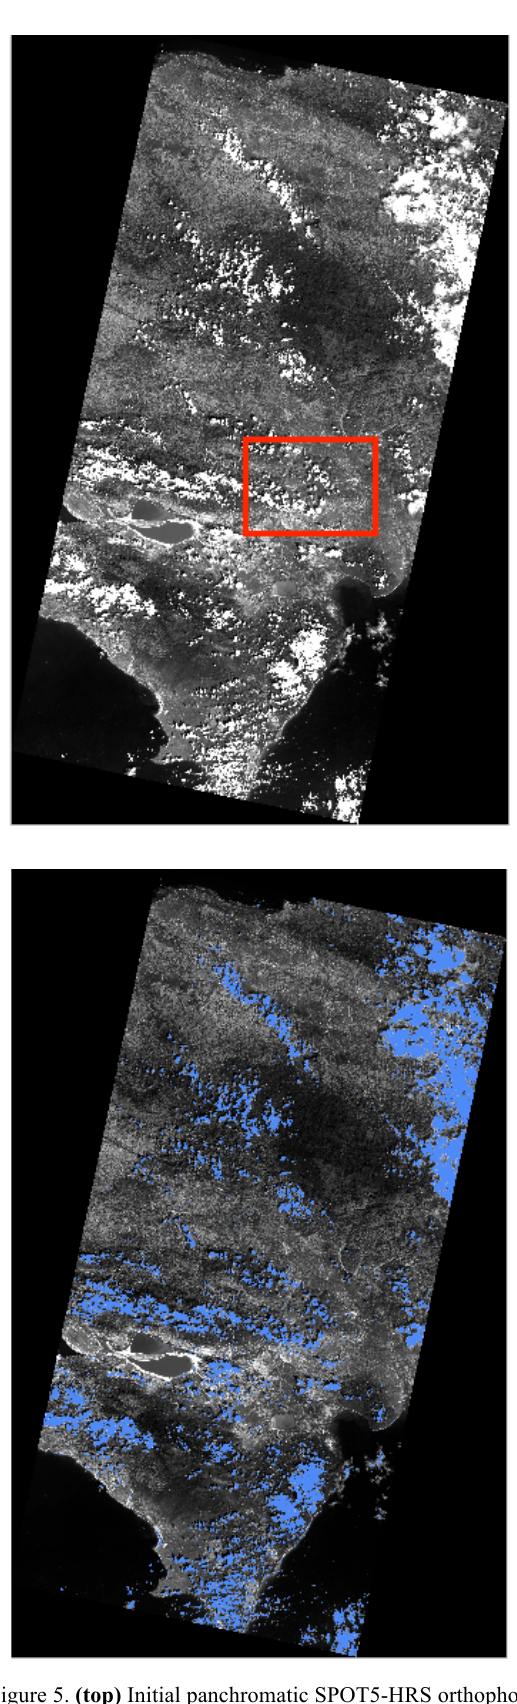
Figure 5. (top) Initial panchromatic SPOT5-HRS orthophoto. (bottom) The outcomes of our cloud detection algorithm. Pixels labelled “clouds” are highlighted in blue.